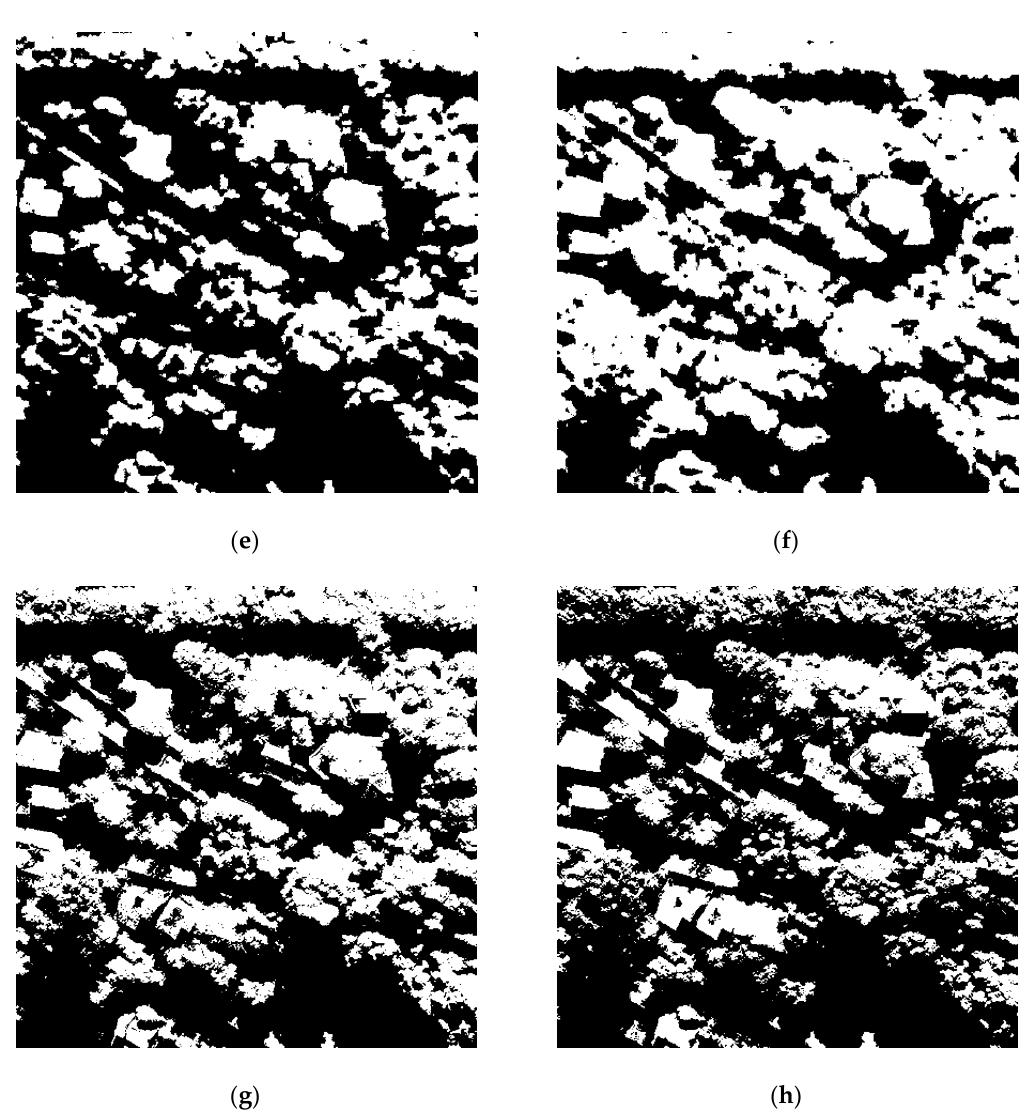
Figure 7. Test image C. ( a ) The original image. ( b ) The reference shadow image. ( c ) Shadow image by the SRI-based algorithm [11]. ( d ) Shadow image by the NSVDI-based algorithm [18]. ( e ) Shadow image by the MC3-based algorithm [20]. ( f ) Shadow image by the SI-based algorithm [14]. ( g ) Shadow image by the SDI-based algorithm [19]. ( h ) Shadow image by the developed MPSI-based approach. Table 1. Shadow detection accuracy data for test image A in Figure 5(a).